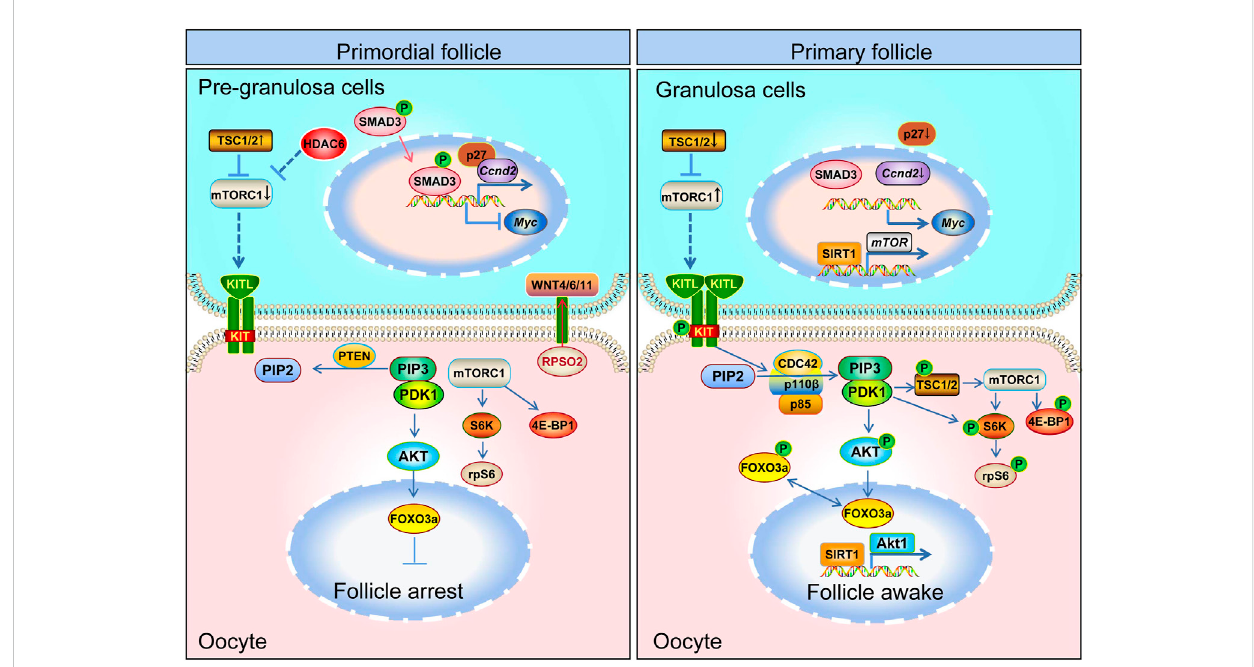
FIGURE 3 Schematicmodeldepictingthemechanismsofprimordialfollicleactivation.Primordialfollicleactivationisaresultofthedelicateinteractionofpre- granulosa cells and oocytes and the follicular microenvironment. The mTOR and WNT pathways in pre-granulosa cells, the mTOR and PI3K pathway in oocytes, and the communication channel (KITL-KIT) between pre-granulosa cells and oocytes are all necessary for primordial follicle activation. The mTOR signaling pathway in pre-granulosa cells initiates and regulates primordial follicle activation in adult ovary. The mTOR signal in the pre- granulosacellssenseschangesinsurrounding nutrients,pressure, etc. ,sothatthepre-granulosacellssecretemoreKITL.AfterKITLbindstothereceptor on the oocyte membrane, it activates the PI3K signaling pathway in the oocyte, and then promotes the primordial follicle